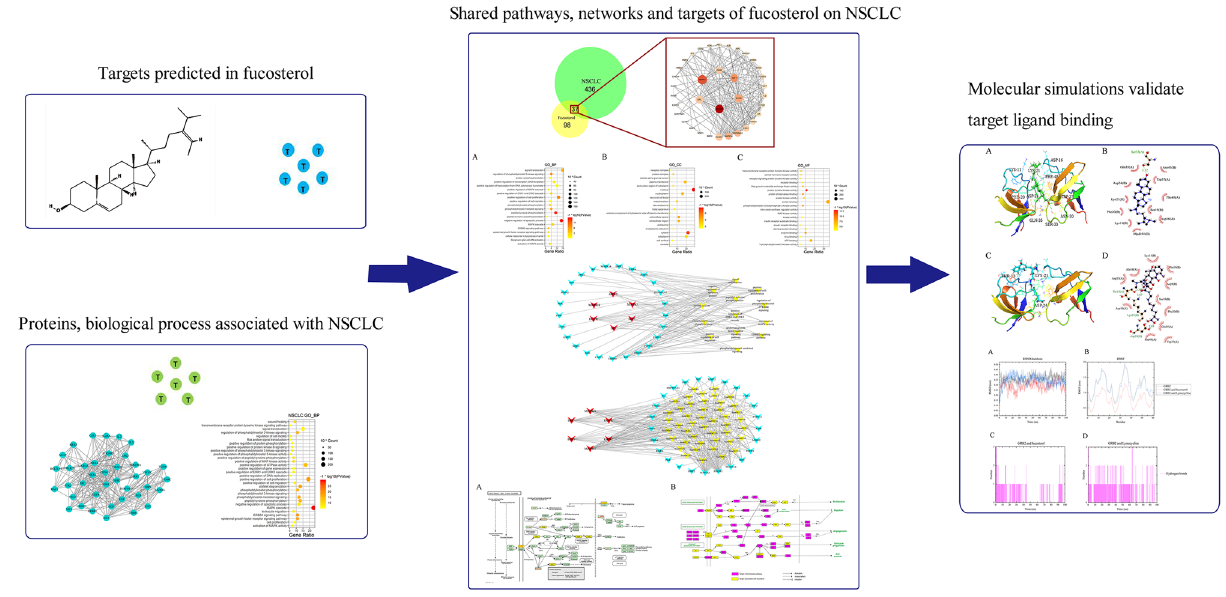
Figure 1. A stepwise workflow showed the mechanism of fucosterol against NSCLC through network